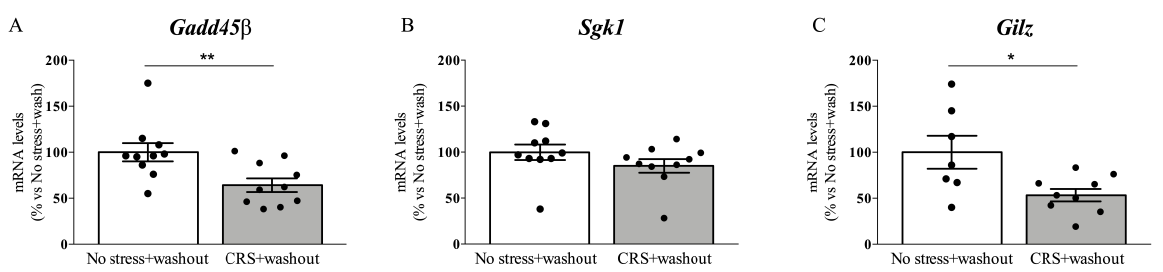
Figure 3. Analysis of Gadd45 β ( A ) Sgk1 ( B ) and Gilz ( C ) mRNA levels in the prefrontal cortex of chronically restraint stressed rats (CRS) after 3 weeks of washout. The data, expressed as a percentage of no-stress animals (set at 100%), are the mean ± SEM. * p < 0.05, ** p < 0.01 vs. No stress (Unpaired t -test).